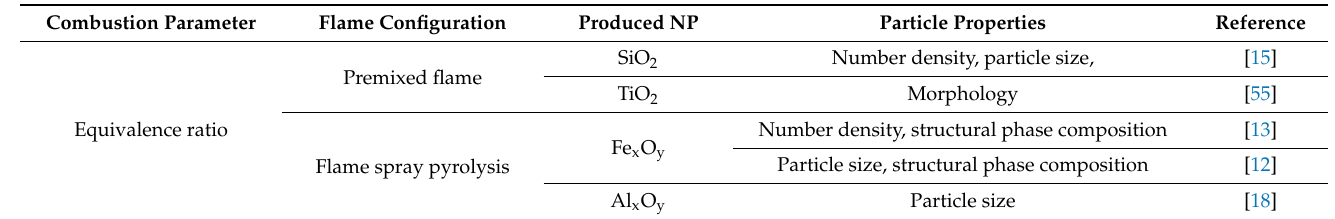
Table 2. Comparison of the combustion parameters analyzed in nanoparticles flame-synthesis, considering the influence over the particle